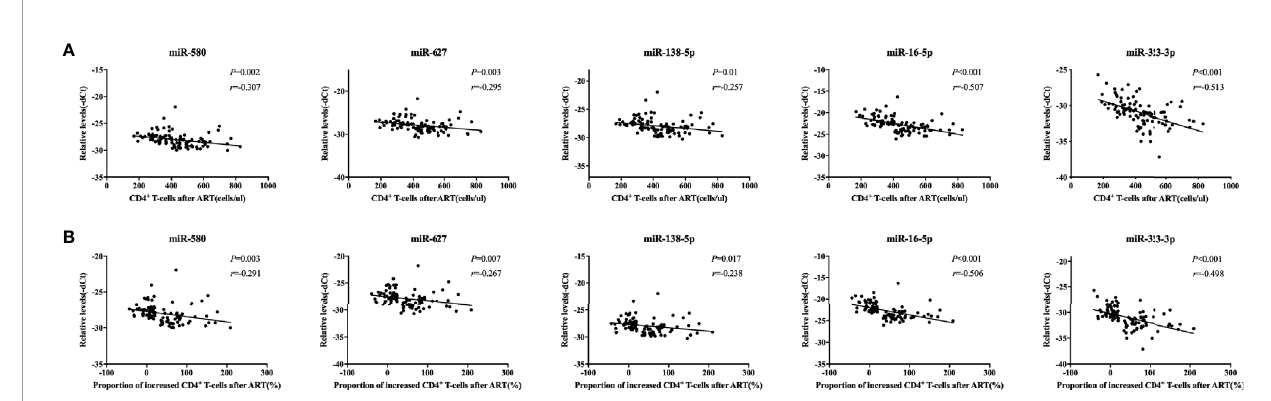
FIGURE 3 | Correlations between relative expression of fi ve microRNAs (miRNAs) and CD4 + T cell counts in people with human immunode fi ciency virus (HIV) infection. Relative expression of all miRNAs was signi fi cantly negatively correlated with the (A) the number of CD4 + T cells and (B) the proportion of CD4 + T cells after antiretroviral therapy (ART) in immune non-responders (INRs, n = 50) and immune responders (IRs, n = 50) in the mixed test set ( p < 0.05). The increase in the proportion of CD4 + T cells was calculated using the following formula: (CD4 + T cell count after ART – CD4 + T cell count at baseline)/CD4 + T cell count at baseline. The y-axis represents the relative expression levels of each